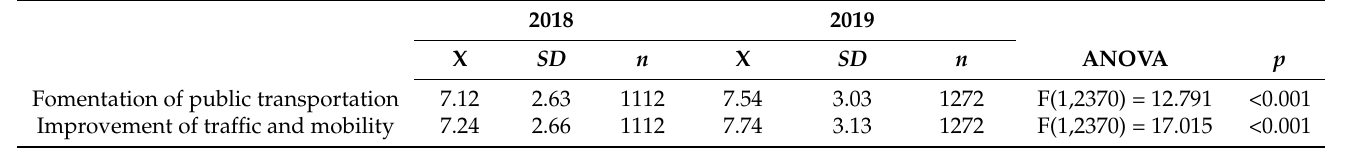
Table 5. Level of perception of apps for the improvement of traffic elements.